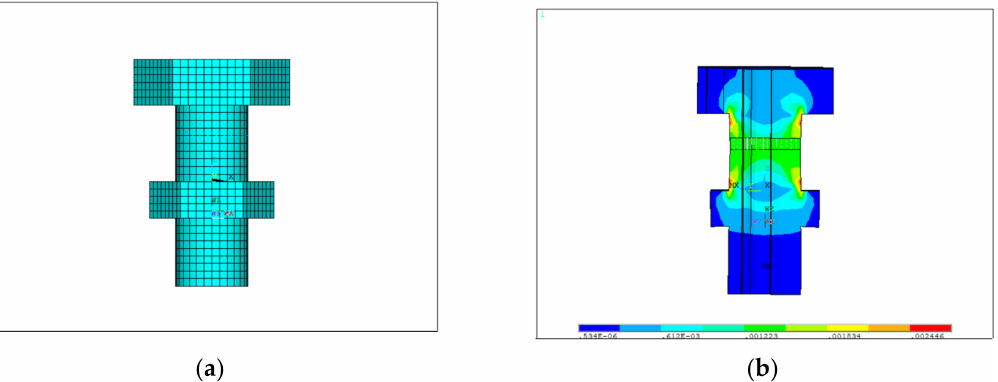
Figure 4. Longitudinal section of a sealing bolt model: ( a ) finite element model; ( b ) simulation results of the von Mises